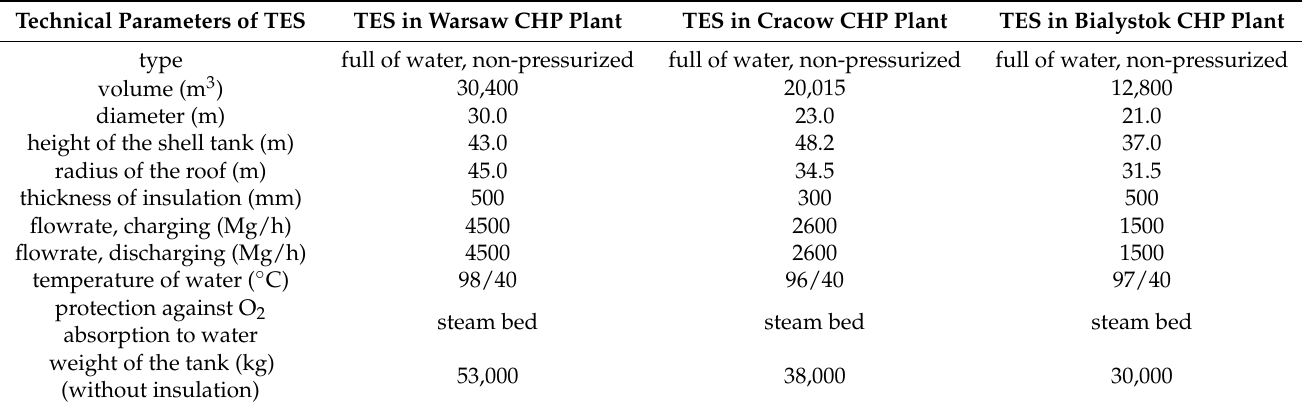
Figure 2. Scheme of the TES tank equipped with SC system. Table 1. Technical parameters of the TES in Warsaw, Cracow and Bialystok CHP plants